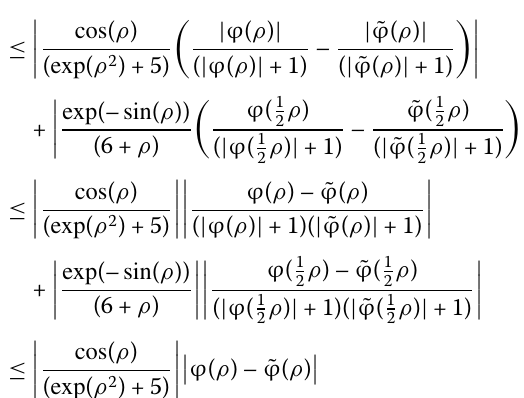
} in Example 5.1 according to Eq. , 1 , 9 10 2 10